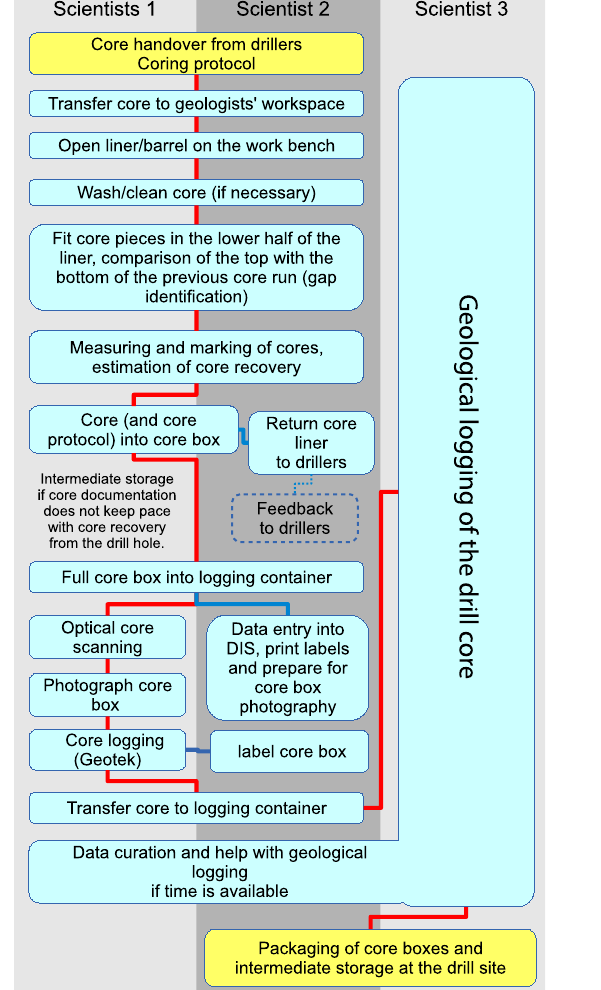
Figure 9. Flowchart over the COSC-1 drill core processing work-